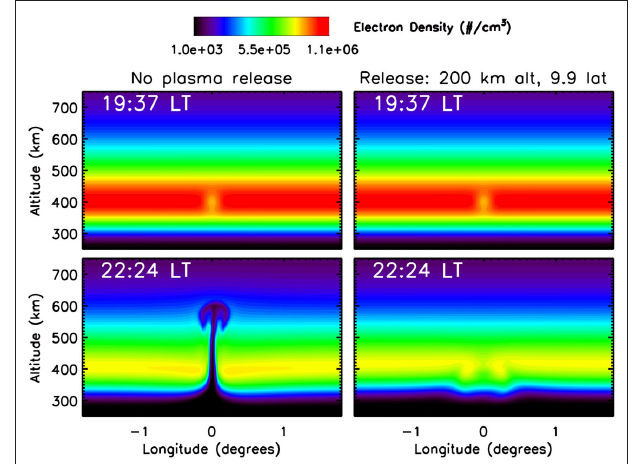
FIGURE 6 | The maximum growth rate in the simulation as a function of injected plasma (Al + )density.